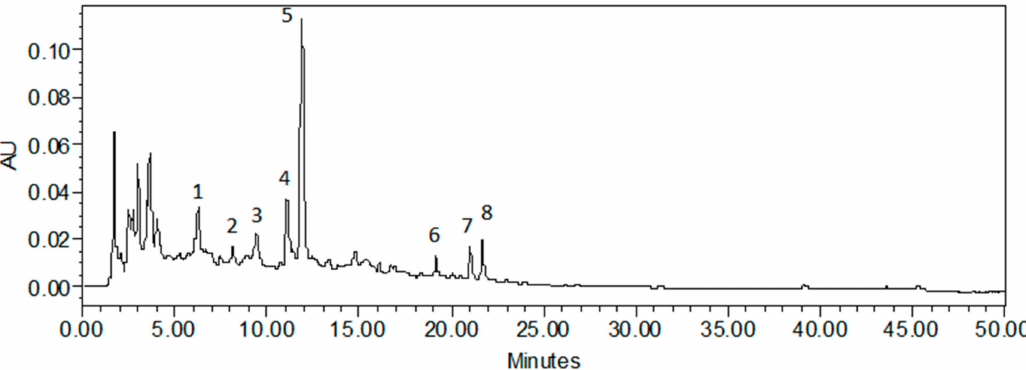
Figure 3. Chromatogram of the 70% aqueous methanol fraction extracted from pericarp of control pepper fruit.